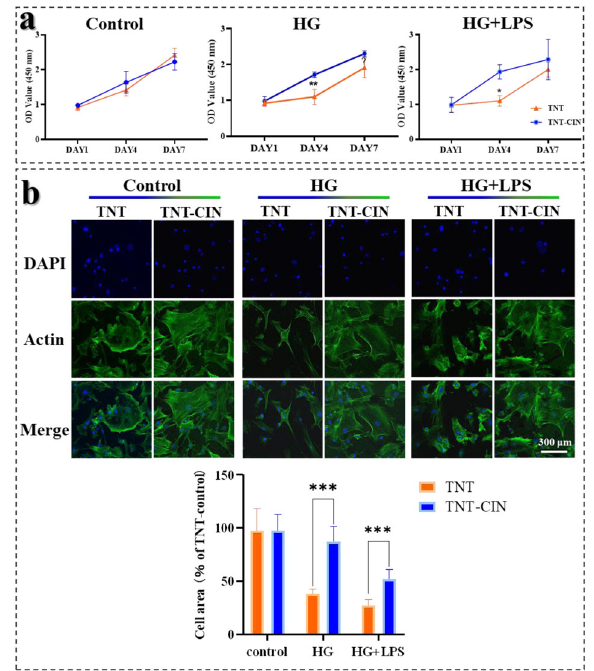
Fig. 2 BMSCs on TNT-CIN showed preferable resistance to HG and HG + LPS as illustrated by better proliferation and spreading on TNT- CIN than on TNT. a The cell proliferation on TNT and TNT-CIN under different culture conditions after 1, 4, and 7 days. b The cytoskeleton staining under different culture conditions after 1 day as observed by confocal scanning laser microscopy and cell area analysis. * P < 0.05, ** P < 0.01, *** P < 0.001. Scale bar = 300 μ